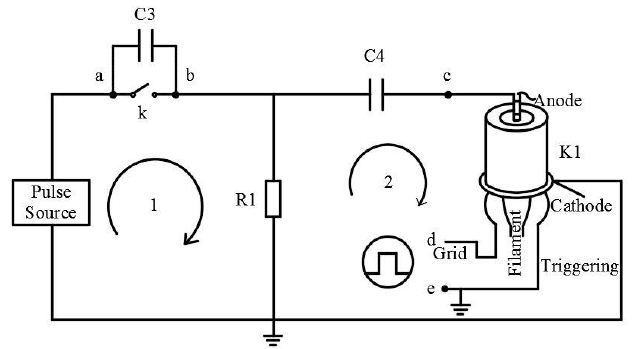
Figure 4. Interference diagram of mutual ground.